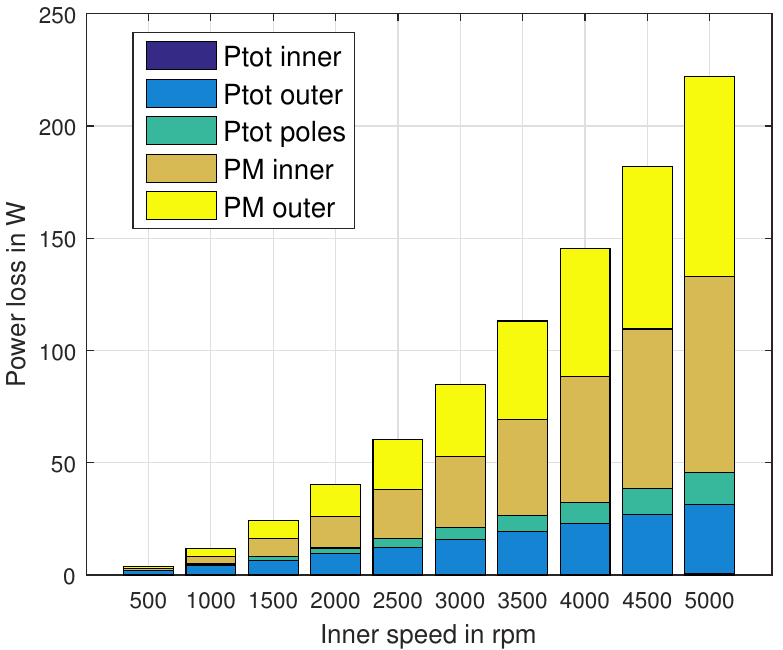
Figure 15. Total inner yoke, outer yoke, iron poles power losses P tot inner , P tot outer , P tot poles and permanent magnets power losses varying the rotational speed. The inner yoke losses are negligible for the efficiency calculation.